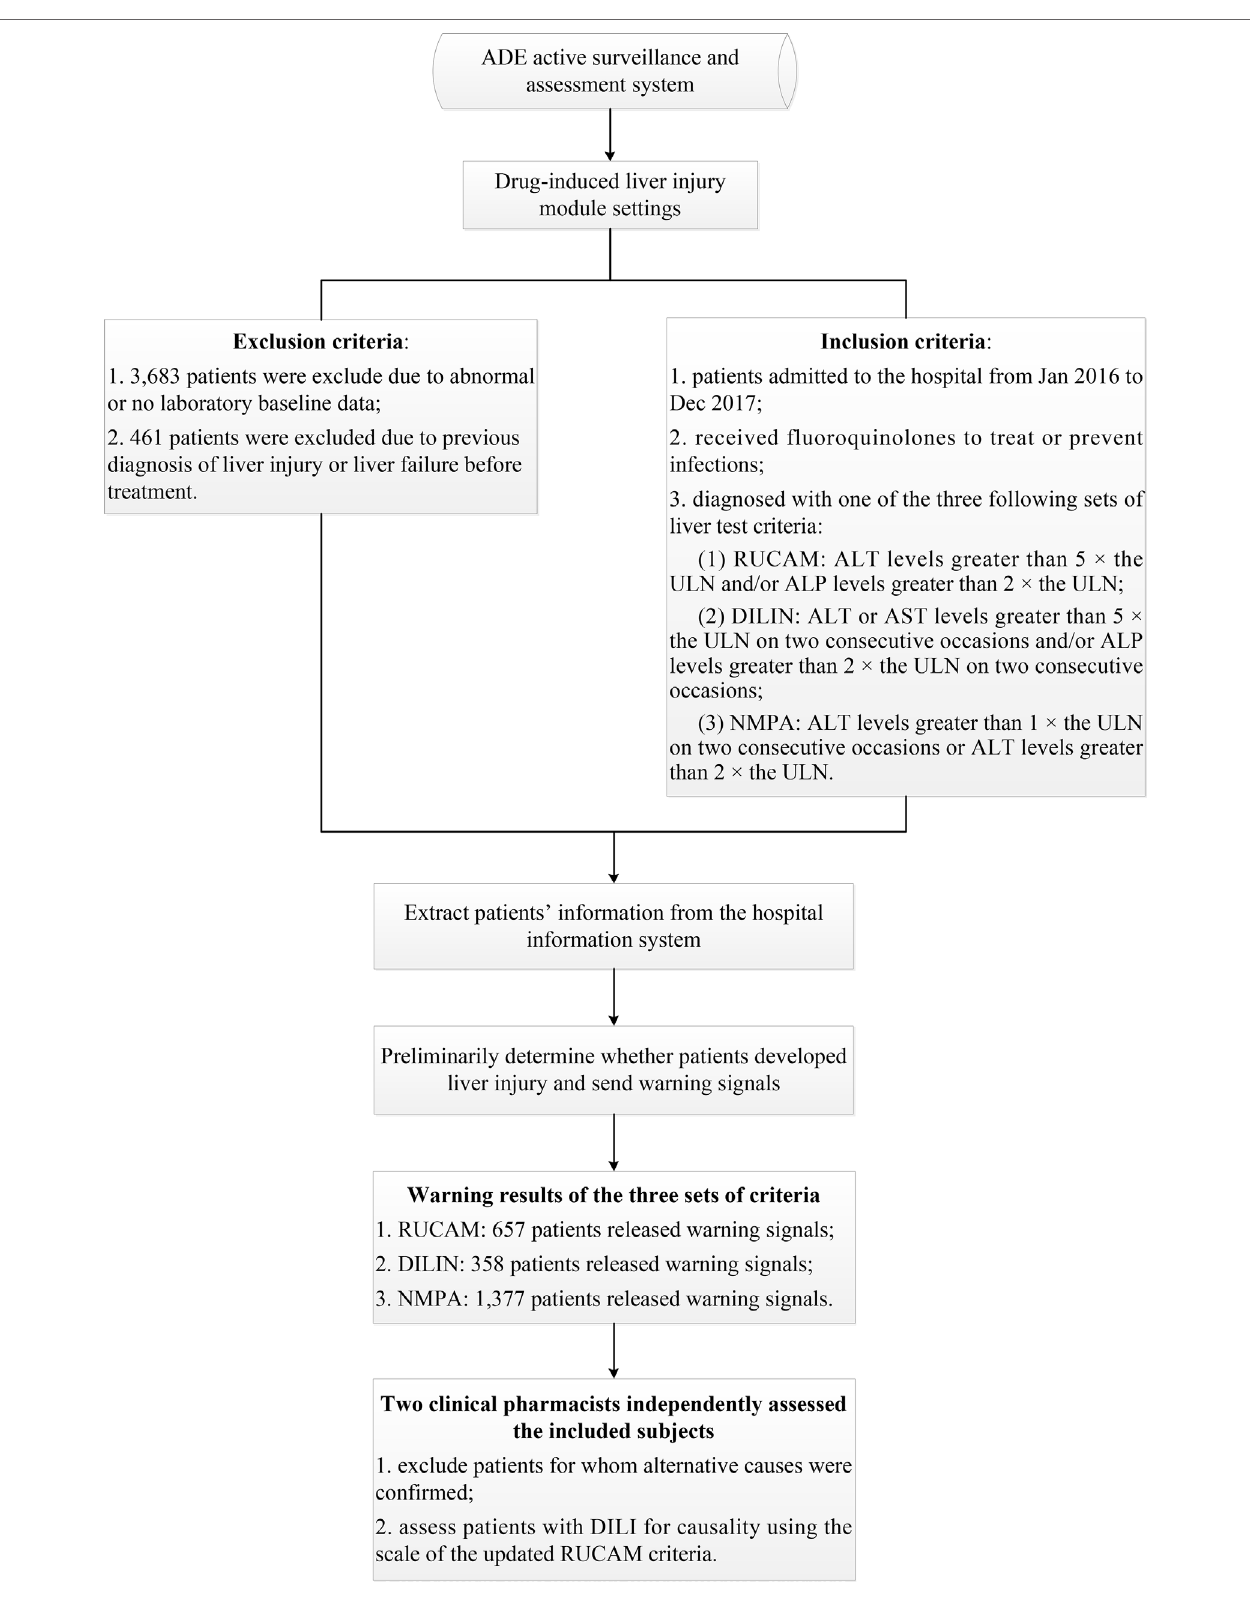
FIGURE 1 | Flowchart of the assessment of positive